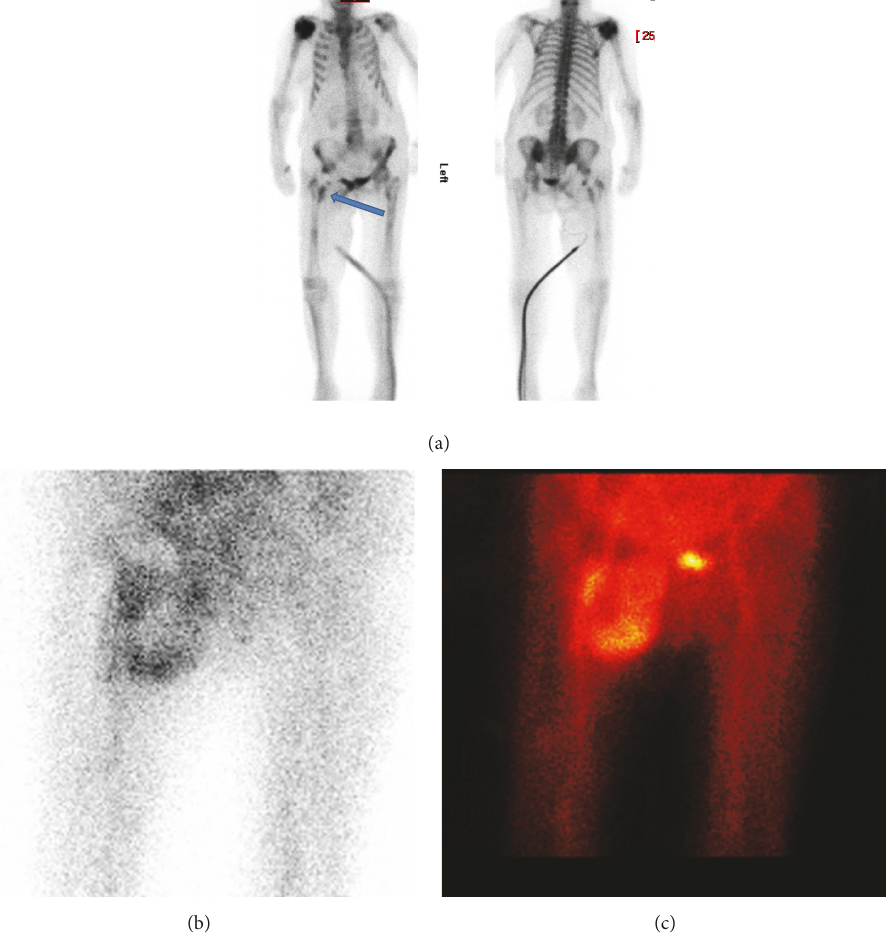
Figure 3: (a) Te 99 bone scan showing increased uptake suggestive of infection. (b and c) The hypervascular abnormality on the early images would be in keeping with a soft tissue abscess with a necrotic centre, possibly related to infection of the right hip prosthesis.